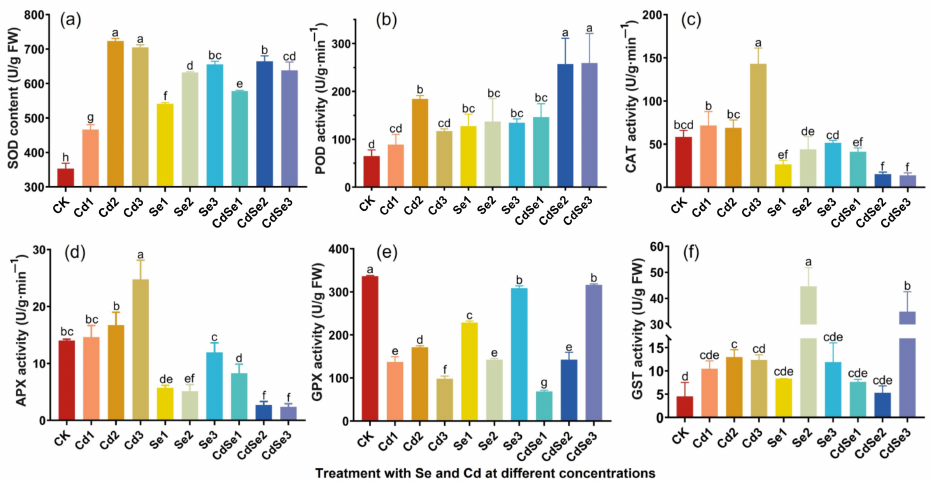
Figure 4. Changes in antioxidant enzyme activity of B. juncea seedlings under different concentrations of Se and Cd. The error bar represents the standard deviation. The lowercase letter a to h on the bar reflects the 5% significance level. ( a ) Superoxide dismutase activity; ( b ) peroxidase activity; ( c ) catalase activity; ( d ) ascorbate peroxidase activity; ( e ) glutathione peroxidase activity; and ( f ) glutathione transferase